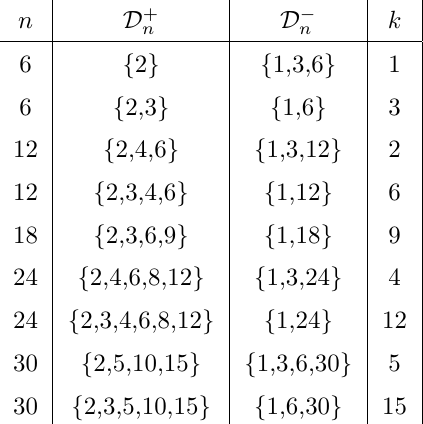
All solutions for N A = 2 and n (cid:20) 30 of the N k family. They are de(cid:12)ned by n ((cid:12)rst column) and the set D + (second column), from which one gets (cid:8) + n is for completeness, and it is unique due to (3.19). The last column specify the integer k of the solution